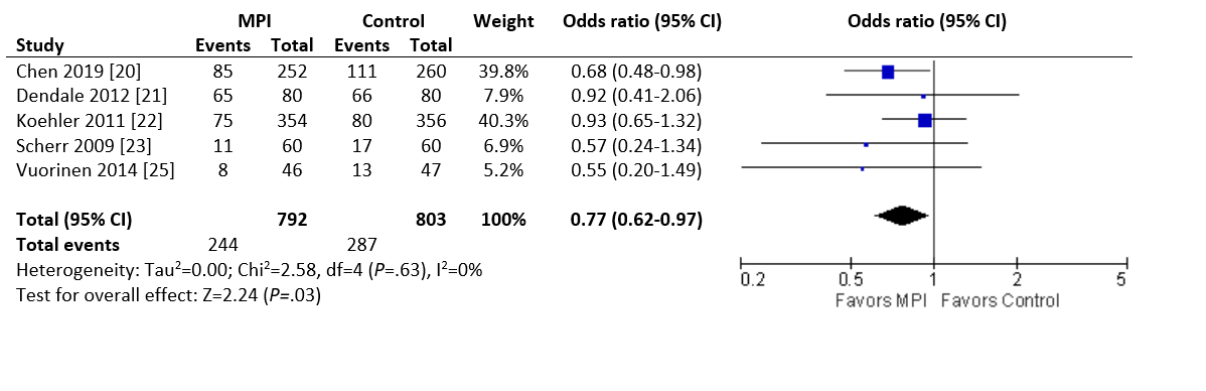
Figure 4. Forest plot of the odds ratio (OR) of all-cause readmissions in patients with heart failure who were involved in randomized controlled trials comparing a mobile phone intervention versus control. The estimate of the OR of each trial corresponds to the middle of the squares, and the horizontal line shows the 95% CI. The summary OR is represented by the middle of the solid diamond. A test of heterogeneity is given below the summary statistics. MPI: mobile phone intervention, df: degrees of freedom.